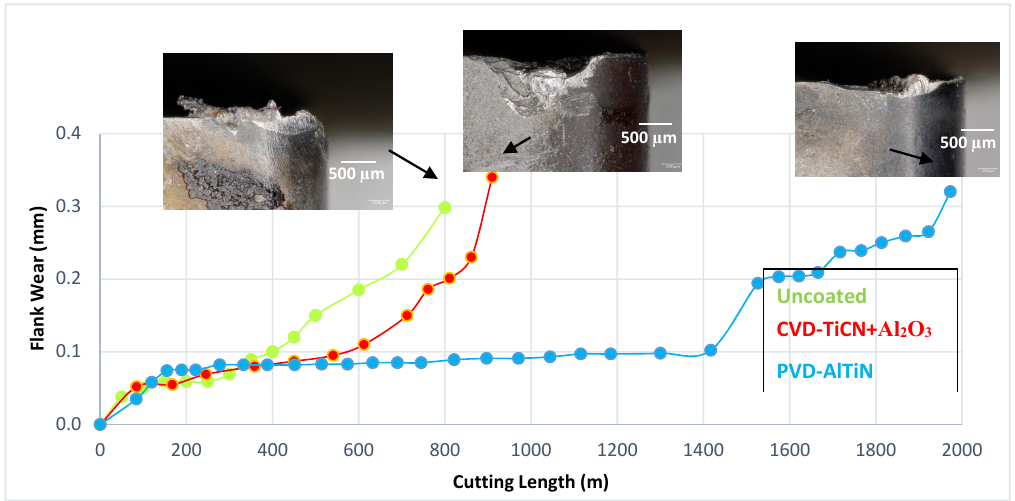
Figure 2. Relation between flank wear and cutting length for uncoated and coated carbide inserts during machining SDSS. Additionally the flank surface for each tool is presented at the end of tool